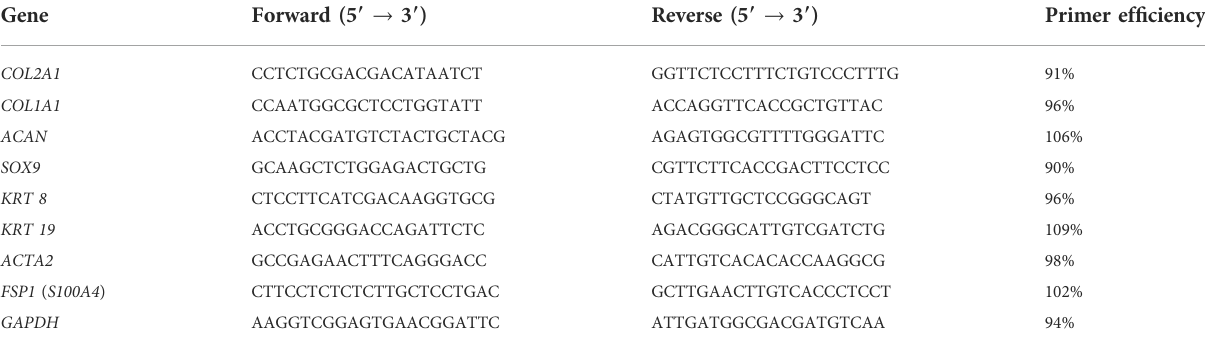
TABLE 1 RT-qPCR list of genes and primer